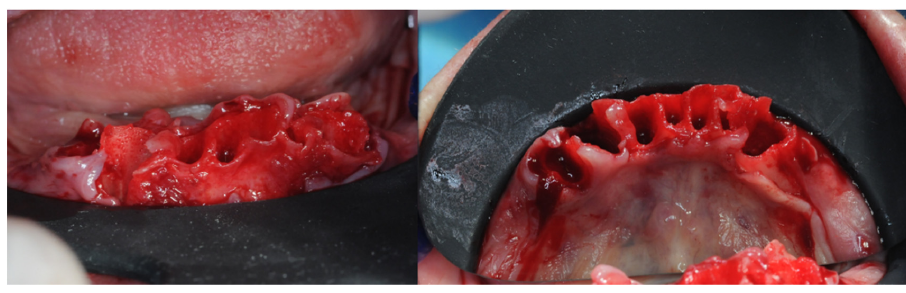
Figure 11. Details of the osteotomy executed with Piezosurgery. The anchor pins of the first template guided the positioning of the second template; thus, the implant alveoli creation process begun (Figure 12).